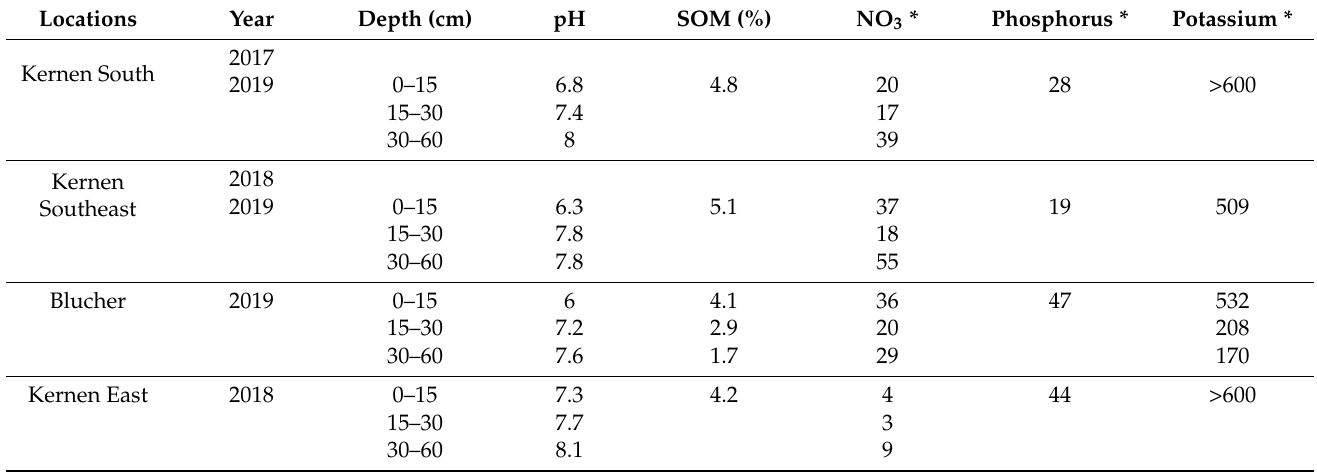
Table A1. Soil properties of 2017–2019 experiment locations in central Saskatchewan, Canada in 2017 and 2019.